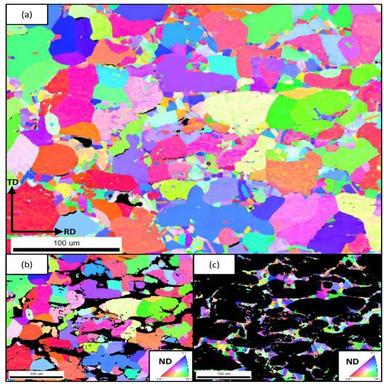
(a) EBSD map of R87 RD-TD indexed in the ND direction. (b) The same region indexing only the W phase showing polygranular W domains with ND IPF color map. (c) The distribution of the Ni-Fe-W phase showing refined grain structure and high density of annealing twin boundaries with ND IPF color map. RD and TD indexing are in supplementary figure S6.